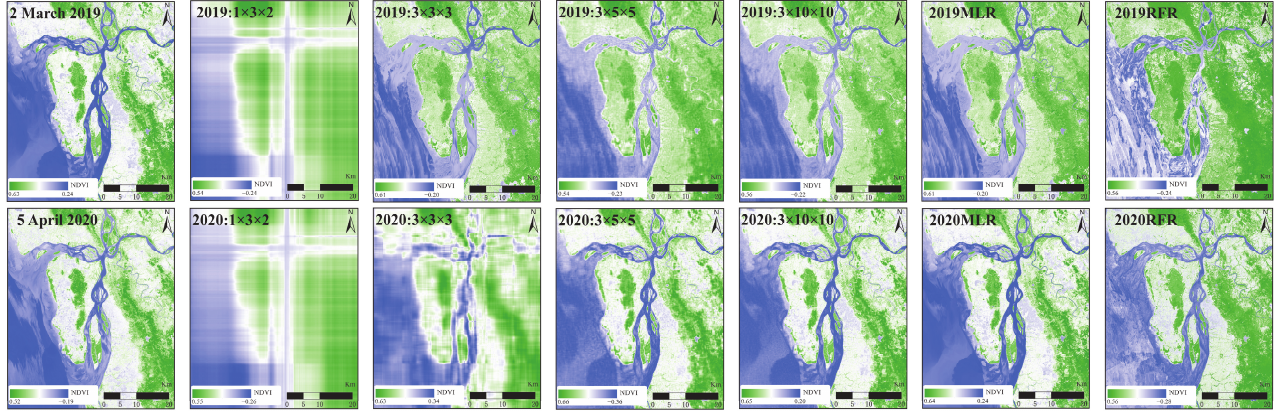
Figure 3. NDVI reconstructed results for different rank